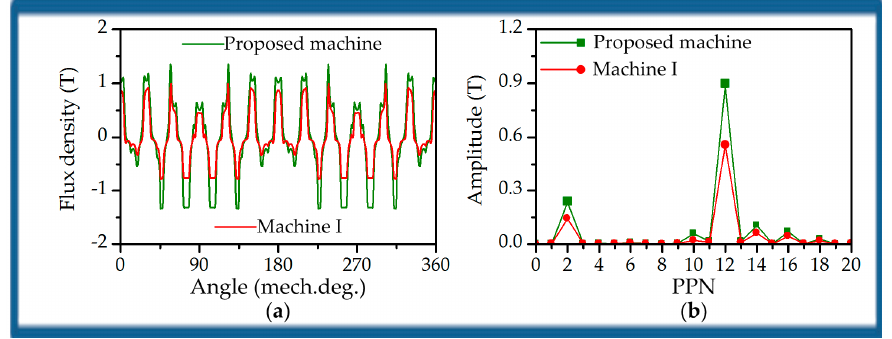
Figure 15. DPME Machines for comparison: ( a ) Proposed machine; and, ( b ) Machine I.